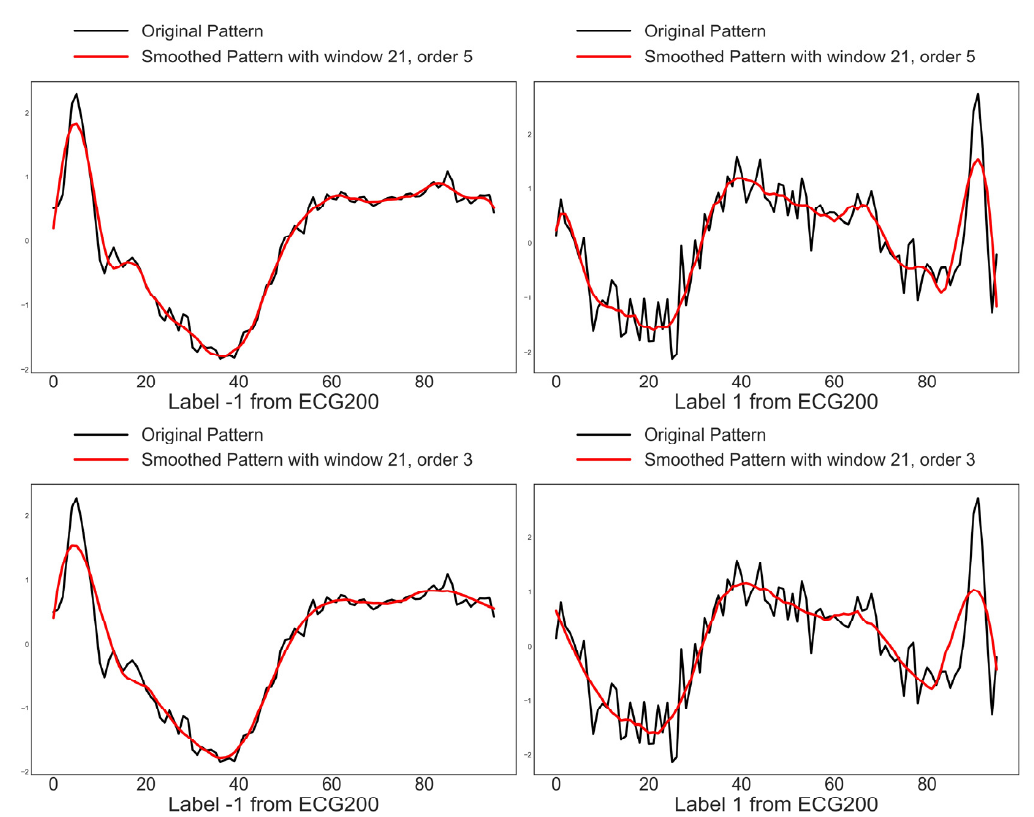
Figure 3. Smoothing effects according to the polynomial orders of Savitzky–Golay filter. The window size was fixed at 21 and polynomial orders were applied to the 2 sample patterns from the ECG200 dataset in the order of 17, 13, 5, and 3, from top to bottom in the figure.